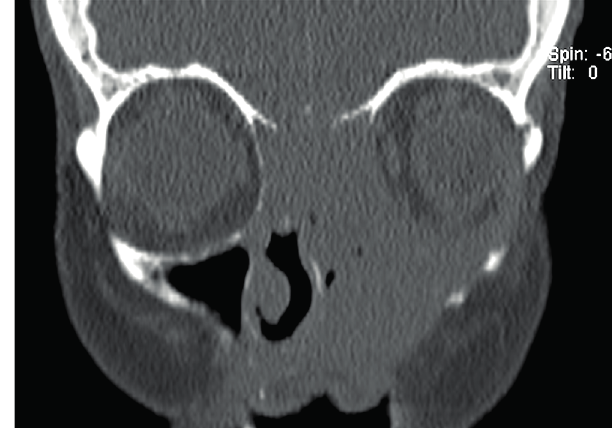
Figure 2. Coronal section of CT scan showing a large mass growing from the left ethmoid into the maxillary sinus, lamina papyracea and orbital floor, extending laterally into the zygoma and caudally into the hard pal- ate. The anterior skull base cannot be delineated accurately.